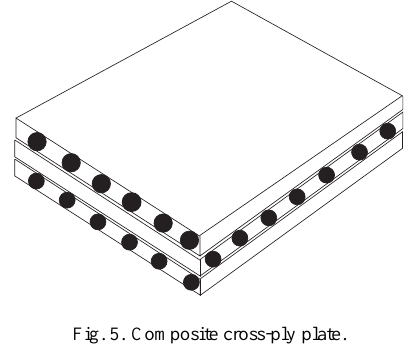
Fig. 5. Composite cross-ply